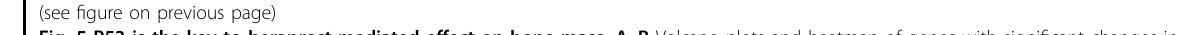
Fig. 5 P53 is the key to beraprost-mediated effect on bone mass. A , B Volcano plots and heatmap of genes with signi fi cant changes in beraprost-stimulated M-BMSCs. C KEGG pathway analysis indicating altered function of the PI3K – AKT pathway. D GSEA showing that processes involved in negative regulation of protein modi fi cation were affected. E Western blot analysis of the transfection ef fi ciency of p53 in M-BMSCs. F Quantitative analysis of ALP activity. n = 5; ** P < 0.01, *** P < 0.001 by ANOVA with Tukey ’ s post-hoc test. G Quantitative RT-PCR of mRNA expression of Runx2, Alp, OCN, OSX, and Nedd4 in M-BMSCs. Results are shown as mean ± SD; n = 5; * P < 0.05, ** P < 0.01, and *** P < 0.001 by ANOVA with Tukey ’ s post-hoc test. H Western blotting images of protein expression of pI3k, p-pI3k, AKT, p-AKT, mdm2, and p53 in M-BMSCs. I Representative images of ALP and ARS staining. J Western blot images showing protein expression of p53 in WT and p53 knockout mice. K Images of gene identi fi cation by DNA electrophoresis. L Representative images of micro-CT reconstruction of distal femurs. M Histomorphometric analysis of the distal femurs. Results are shown as mean ± SD; n = 5; * P < 0.05, ** P < 0.01, and *** P < 0.001 by ANOVA with Tukey ’ s post-hoc